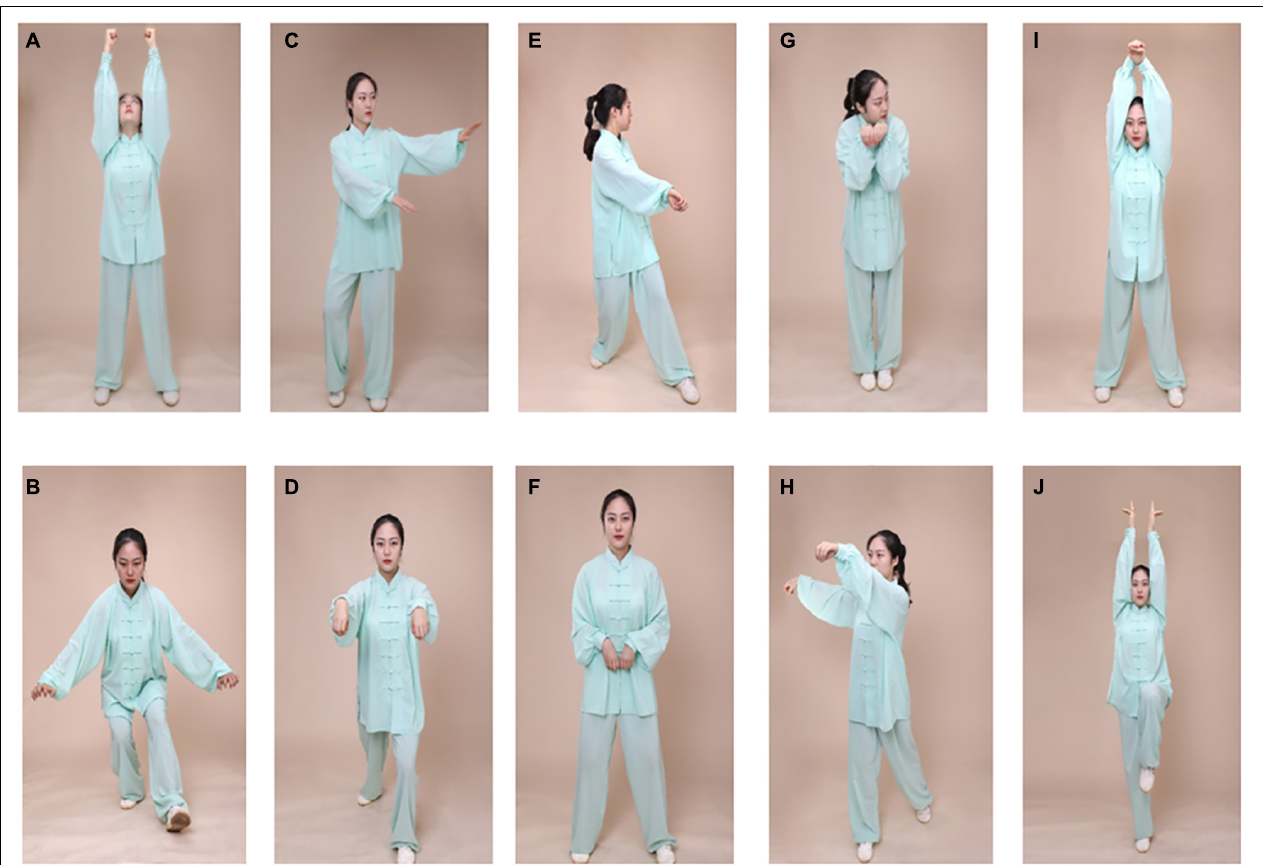
FIGURE 2 | Illustration of Wuqinxi exercise maneuvers. (A,B) Tiger exercise; (C,D) deer exercise; (E,F) bear exercise; (G,H) monkey exercise; (I,J) bird exercise. Written informed consent for publication of the pictures was obtained from the poster demonstrator.